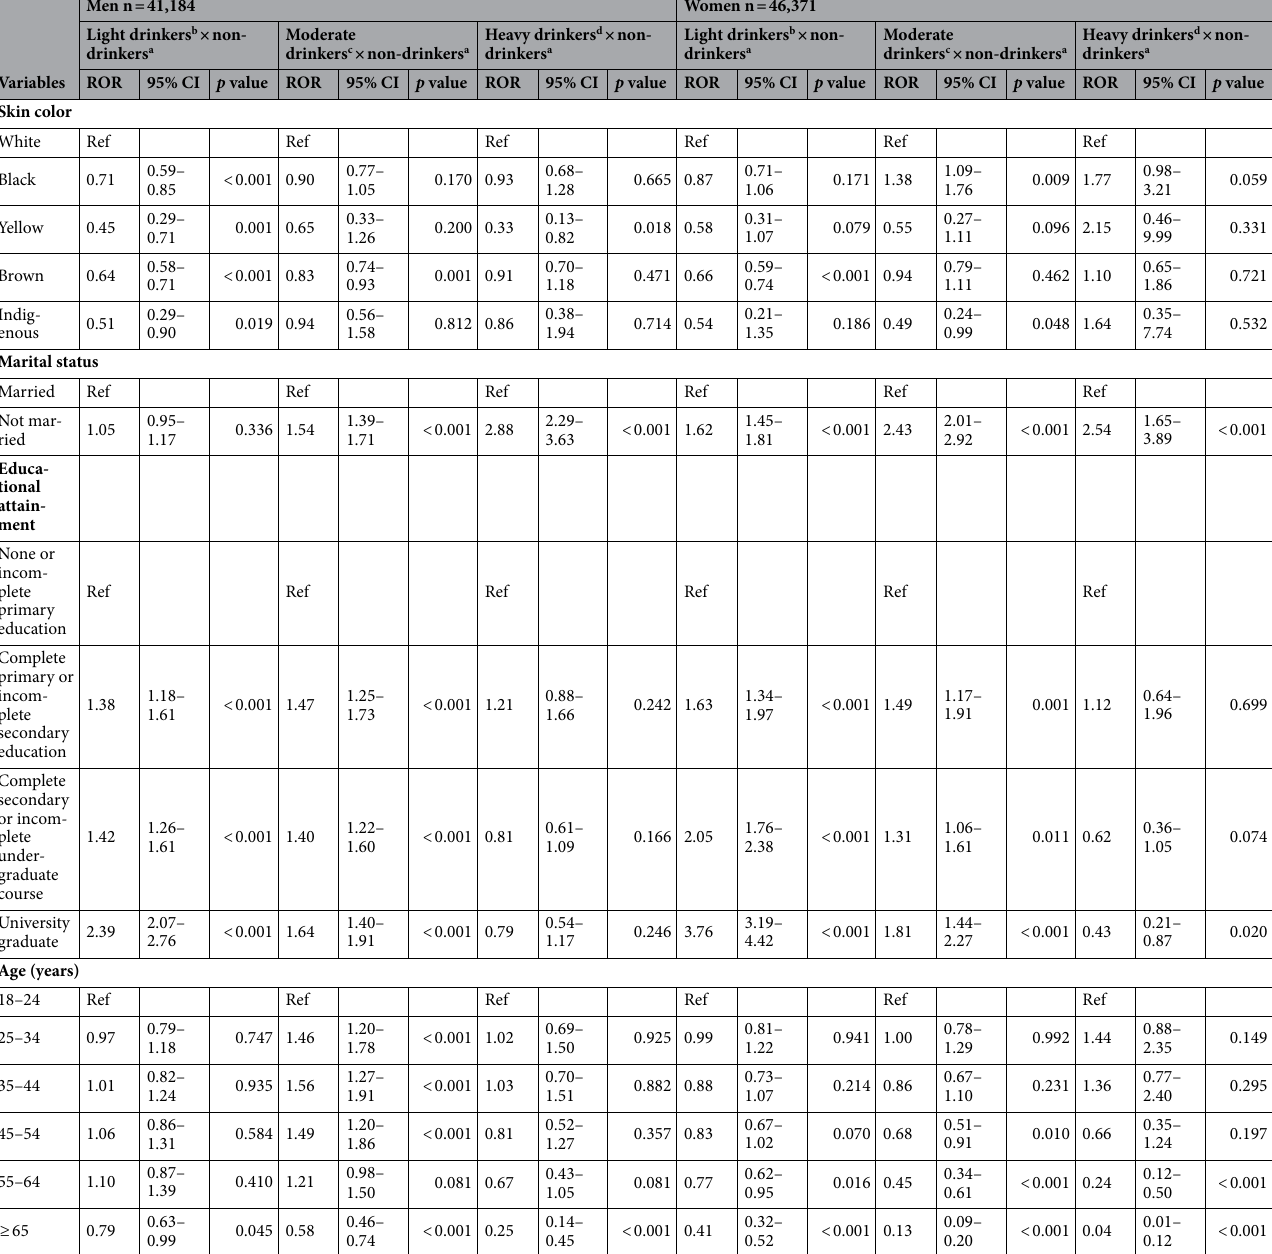
Table 2. Multivariable multinomial logistic regression for the association between sociodemographic characteristics and patterns of alcohol consumption by sex (N = 87,555). Results include sample weights and control for survey design. a Defined as reporting having 0 g/day of pure alcohol in the past 30 days. b Defined as reporting having between 1 and 12.5 g per day of pure alcohol in the past 30 days. c Defined as reporting having between 12.6 and 49.9 g per day of pure alcohol in the past 30 days. d Defined as reporting having between ≥ 50 g per day of pure alcohol in the past 30